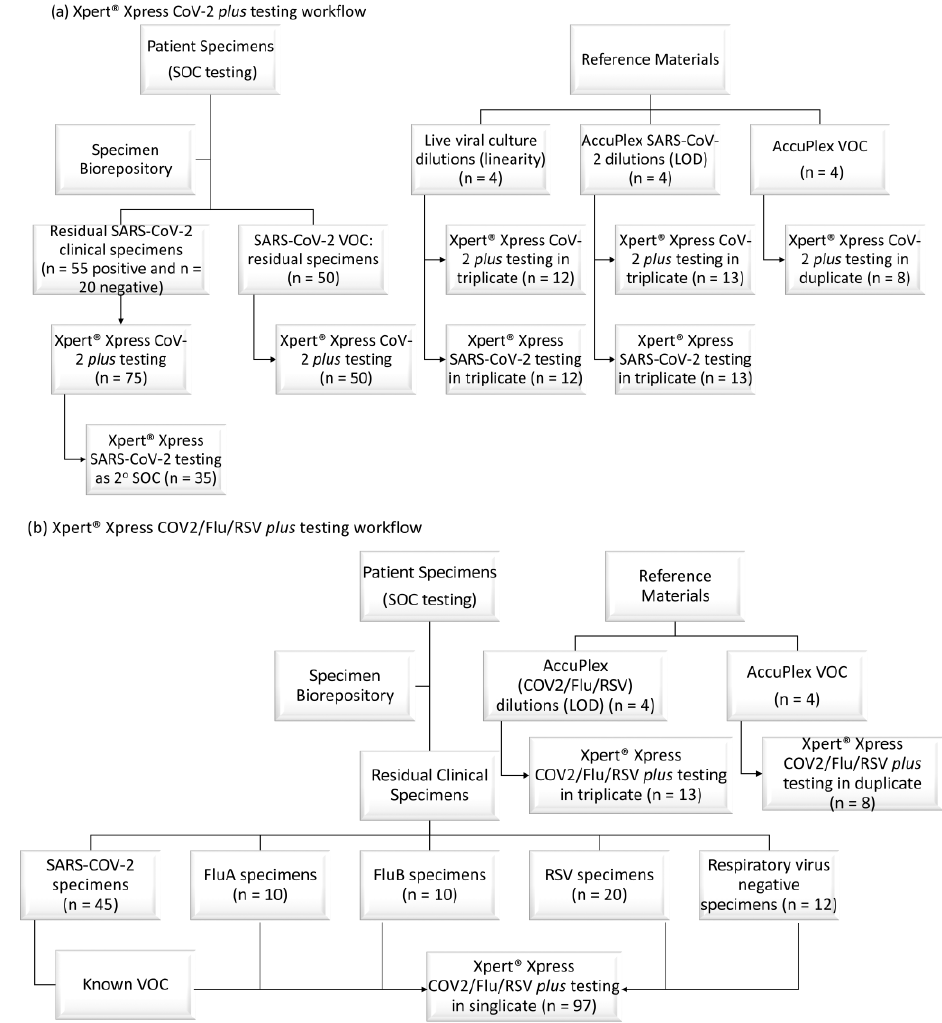
Figure 1. ( a ) Xpert ® Xpress CoV-2 plus workflow and ( b ) Xpert ® Xpress CoV-2/Flu/RSV plus work- flow. 2 o : secondary; LOD: limit of detection; n: number; SOC: standard of care; VOC: SARS-CoV-2 variants of concern.